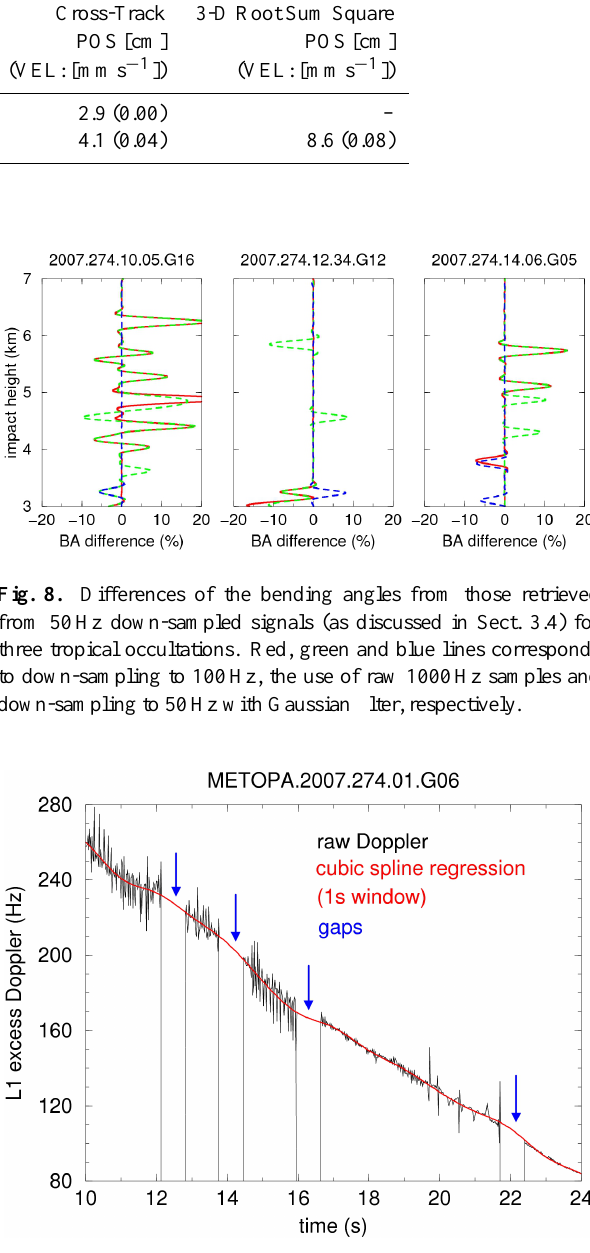
Fig. 9. Filling gaps in Metop/GRAS PLL Doppler data with cubic spline